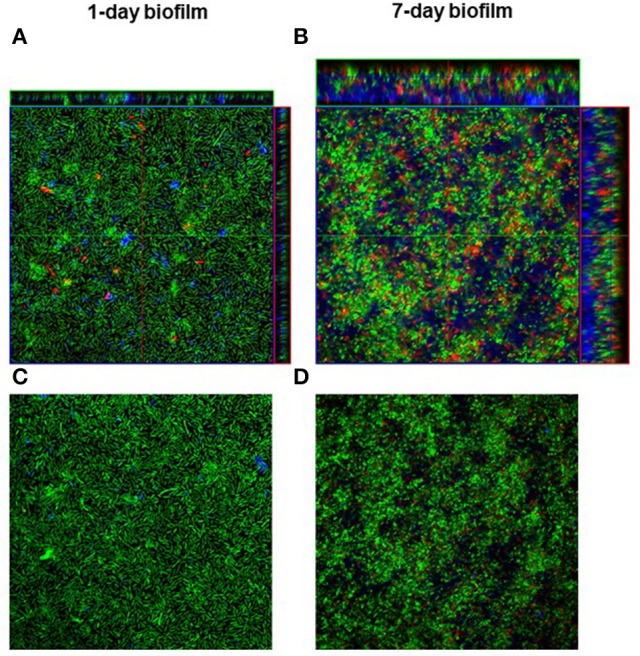
Confocal laser scanning microscopy of Myroides odoratimimus biofilm. Biofilm was allowed to grow, for 1 and 7 days, in collagen gel matrix in SWF (pH 7.2 and glucose 12.5 mM), and stained with BacLight Live/Dead kit. Green fluorescence: live cells; red fluorescence: dead cells; blue fluorescence: extracellular polymeric substance. (A,B) “multi-stack” reconstruction of the sample, with lateral x-y projections. (C,D) planar images.